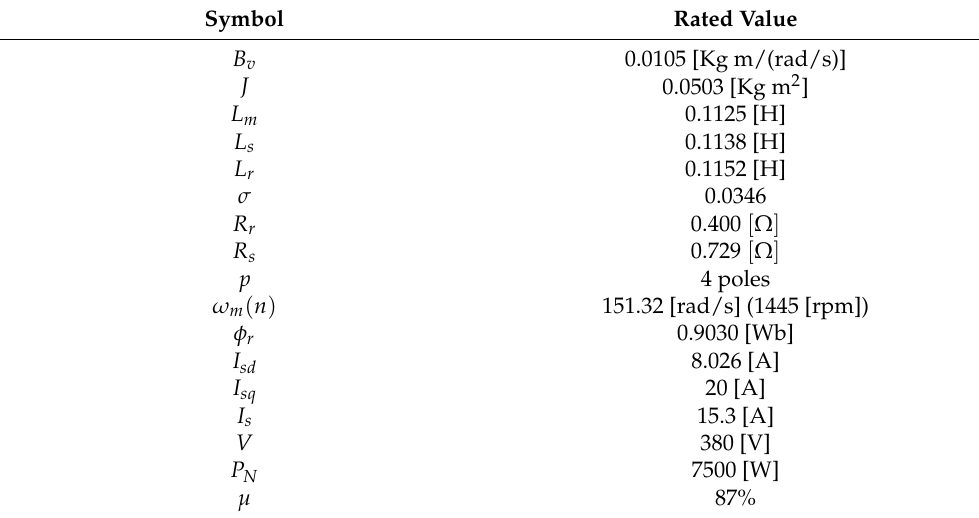
Table 2. Parameters of the M2AA 132M4 ABB Induction Motor 7.5 [rpm] and 1445